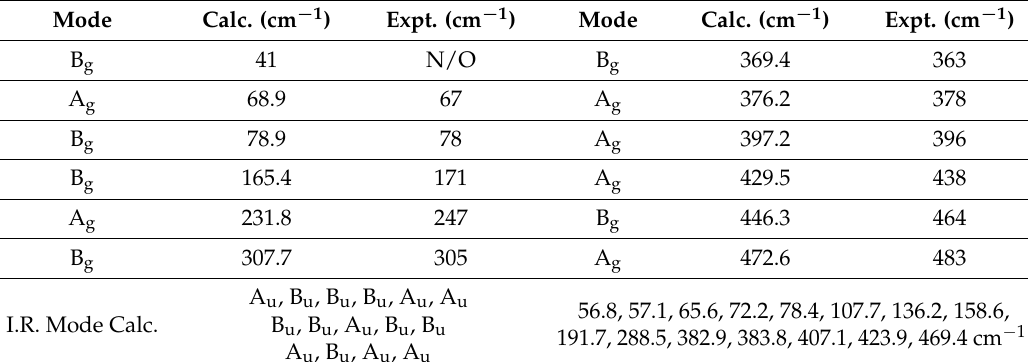
Figure 2. ( a ) High-angle annular dark field (HAADF) image of film cross-section (top) and energy- dispersive X-ray spectroscopy (EDS) chemical maps of P (middle) and Au (bottom); ( b ) High-resolution TEM of film and measured layer spacing; ( c ) Schematic of the Au 2 P 3 monoclinic crystal structure where the orange atoms are Au and the black atoms are P. The red plane corresponds to the (110). Table 1. Calculated vibrational modes and measured Raman modes for Au 2 P 3 . I.R. = infrared, N/O = not